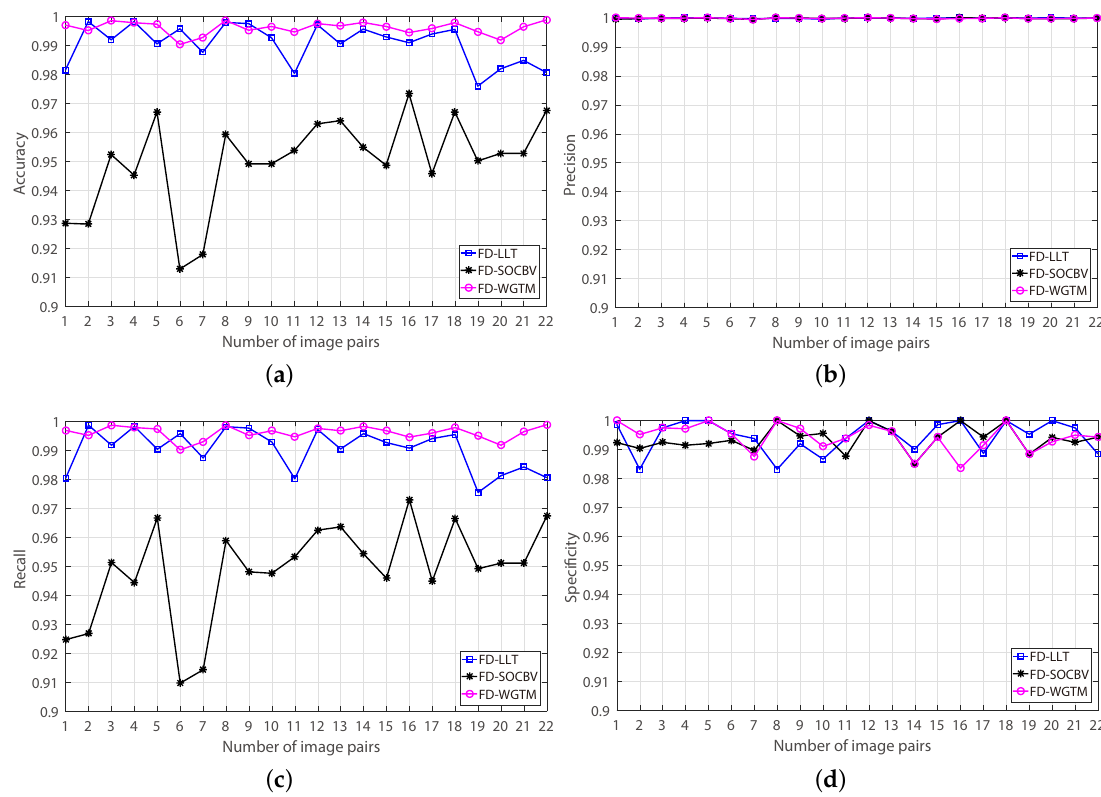
Figure 13. Manual evaluation results of the three algorithms based on FD model for 22 pairs of HiRISE images (the 1 and 2 are training pairs, the rests are testing images pairs). ( a ) Accuracy. ( b ) Precision. ( c ) Recall. ( d )